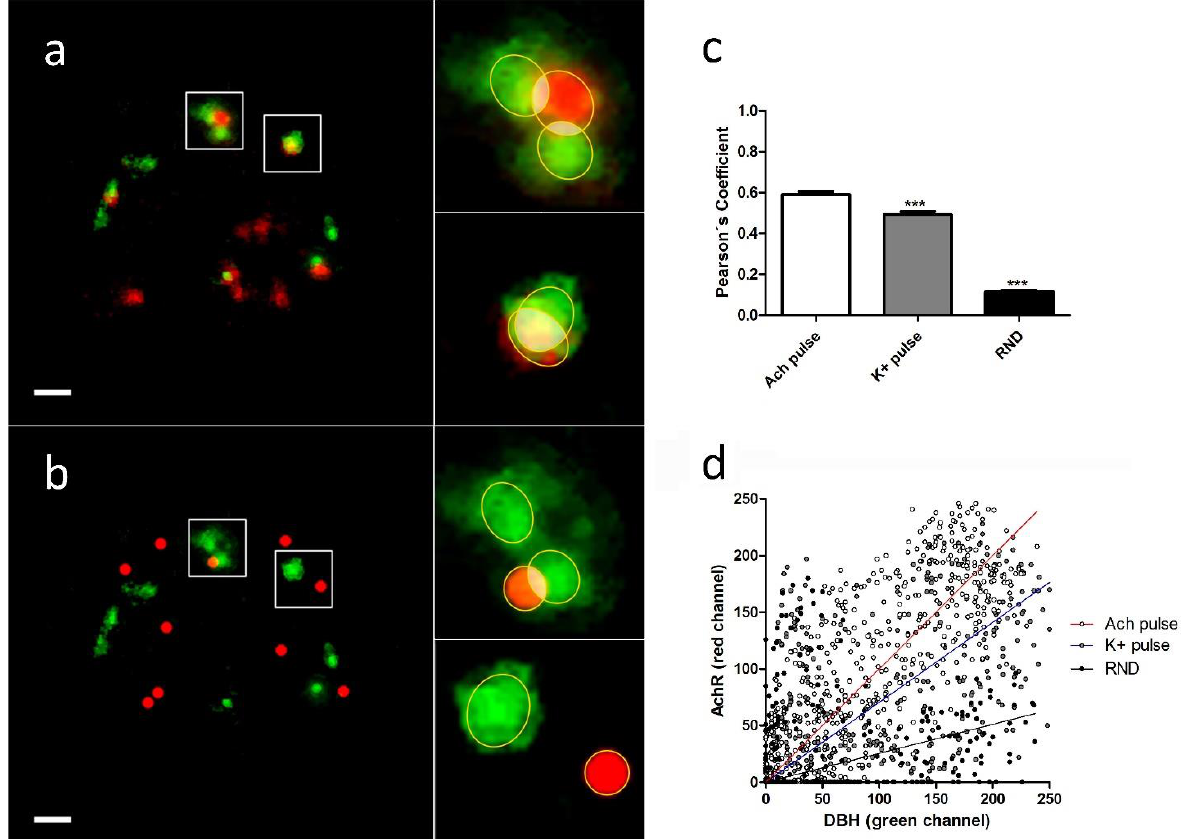
Figure 3. Membrane colocalization and overlapping between α3β4 nAChR (red) and DBH (green) after secretion stimulus: in each image we individually selected several regions of interest (ROIs) ( a , b ) and proceeded to analyze them using ImageJ JACoP complement (See Section 4.6), obtaining the values of the Pearson’s and Manders coefficients, whose averages are shown in Table 1, as well as their corresponding scatterplot graphs, whose examples are shown ( d ). The averaged Pearson’s coeficients for 50% threshold images show a significant colocalization between endogenous α3β4 nAChRs structures and the DBH sites in both stimulation conditions to those obtained for randomly simulated α3β4 nAChRs structures ( Table 1 ( c )). Furthermore, the averaged coefficients obtained for the stimulus with ACh are significantly higher than those obtained when stimulating with a high K + ( p value *** < 0.0001; Table 1). ( d ) A scatterplot or fluorogram for pixel colocalization of the red channel (AChR structures) and green channel (DBH) comparing three examples of the images obtained in each of the three analyzed conditions. Bars represent 1 µm.